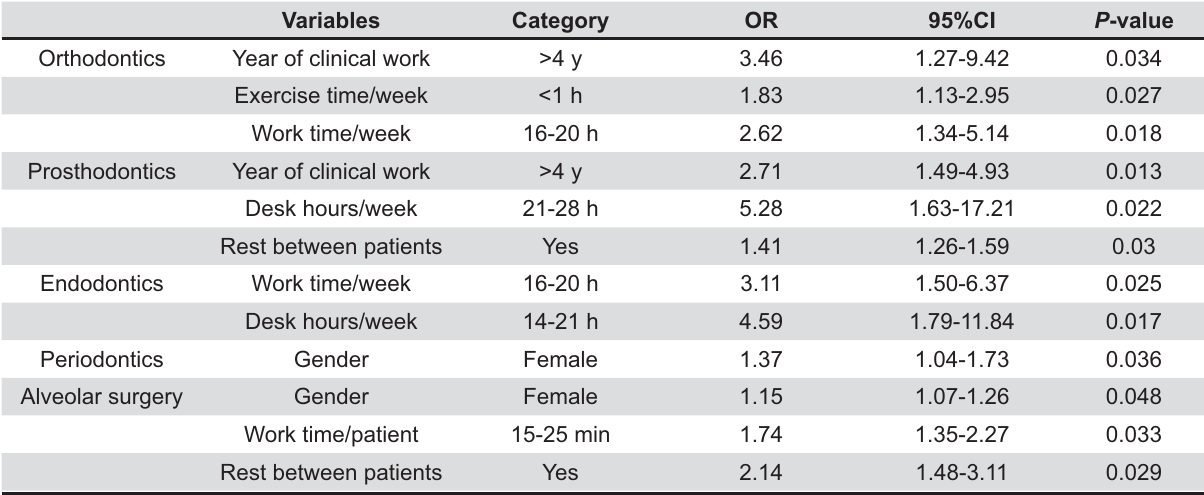
Table 3- Risk factors of Musculoskeletal disorders (MSDs)